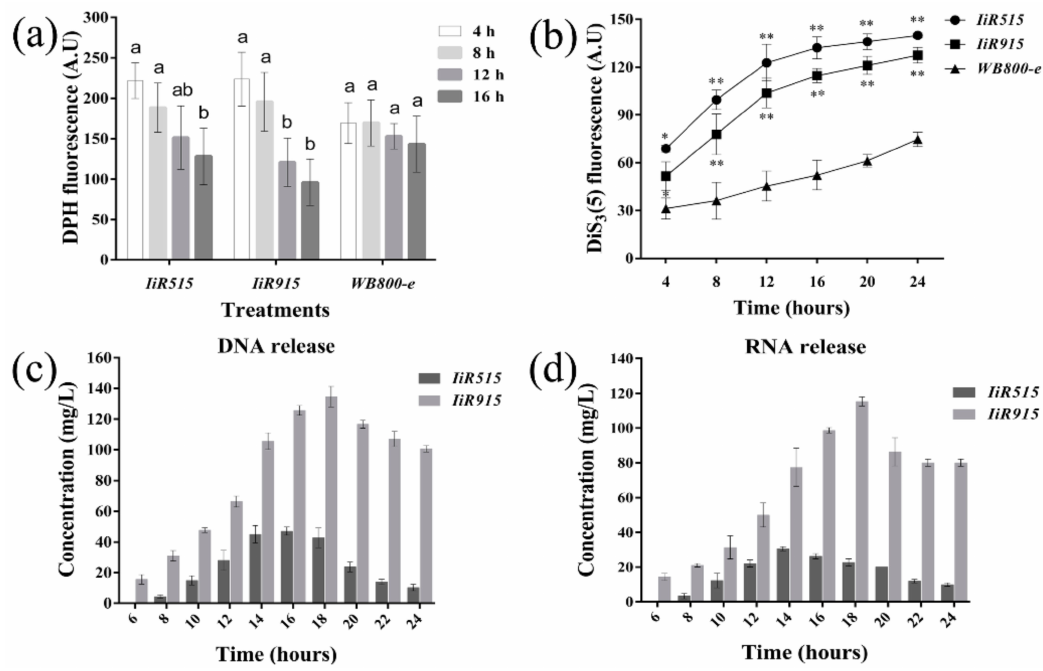
Figure 3. Fluorescence intensity and nucleic acid release of B. subtilis cells. The fluidity and electrical potential of the cytoplasmic membrane of B. subtilis were measured. Excitation and emission wavelengths for ( a ) The DPH were 365 nm and 425 nm and for ( b ) DiSC 3 (5) were 622 nm and 670 nm, respectively. The WB800-e strain was used as a control. The detection of released DNA and RNA was also performed. The empty vector was used as a blank control. ( c ) The concentration of DNA and ( d ) RNA in shaking media at di ff erent time intervals. Data are the mean values from three individual experiments. Vertical bars represent the SD (Standard deviation). For significance analysis, t -tests were performed; * p < 0.05, ** p <